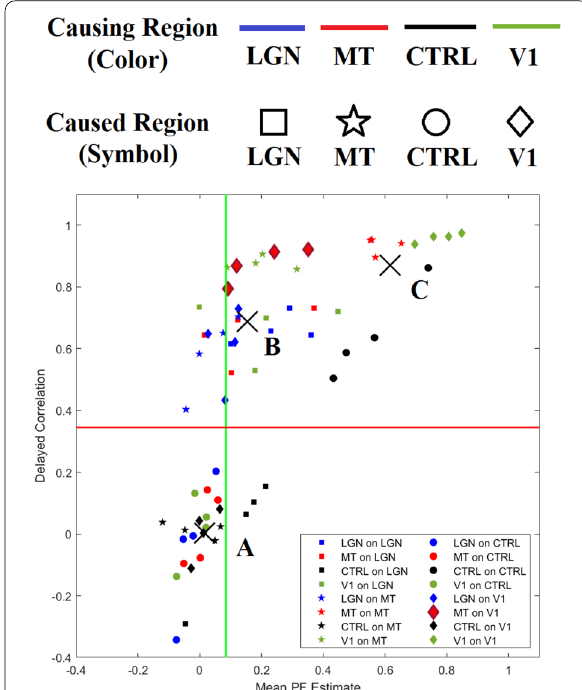
Fig. 11 Figure 8a with ROI-based encoding, explained in the legend above the figure: same color refer to the same causing ROI and same symbols to same caused ROI. Black crosses are clusters centroids found through the Matlab function kmeans() , called A, B and C as in figure. The horizontal red line and vertical green line intersect in the point equally distant from centroids A and